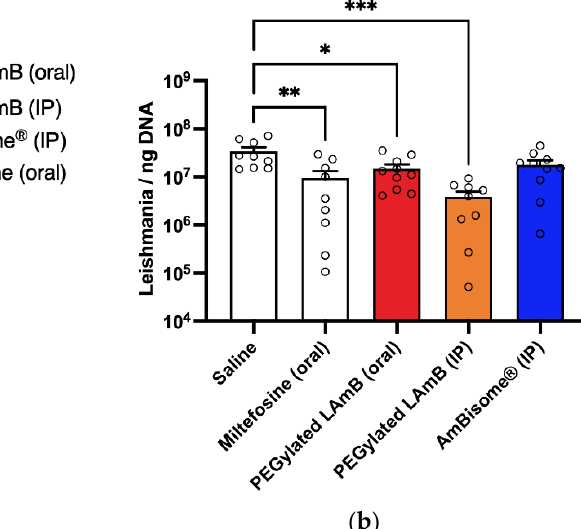
Figure 6. Antileishmanial efficacies of PEGylated liposomal AmB by oral route in comparison with IP route in murine model of cutaneous leishmaniasis. BALB/c mice were infected intradermally with Leishmania amazonensis . Treatments were initiated 75 days after infection with 10 doses of the following formulations. PEG-LAmB (oral) group received the PEGylated liposomal AmB formulation at 5 mg/kg, every 2 days by oral route; PEG-LAmB (IP) group received the PEGylated AmB liposomal AmB formulation at 5 mg/kg, on alternate days by IP route; AmBisome ® (IP) group received AmBisome ® at 5 mg/kg, every 2 days by IP route; Miltefosine group received miltefosine at 10 mg/kg, on alternate days by oral route; Saline group received isotonic saline by IP route. Treatment efficacy was evaluated through measurement of lesion size growth ( a ), analyzed by two-way ANOVA for repeated measures) and determination of parasite load by qPCR ( b ). ( b ) Data are shown as means + SEM and analyzed through one-way ANOVA followed by Tukey’s multiple comparison post-test. * p < 0.05, ** p < 0.01, *** p < 0.001 and **** p < 0.0001.